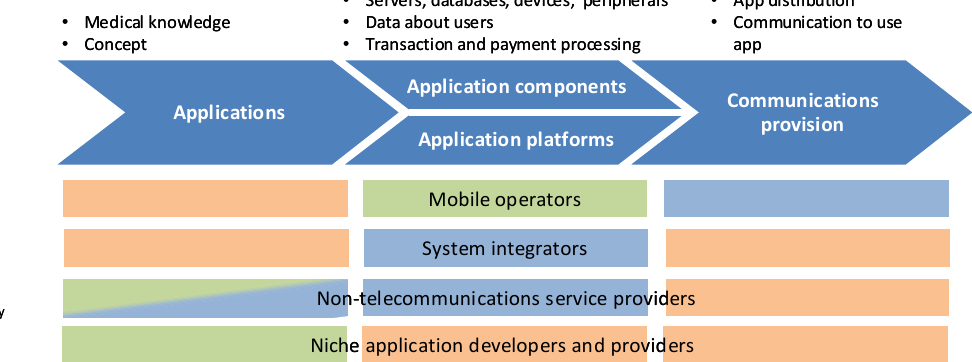
Figure 0: Potential for value capture by main actors in mHealth